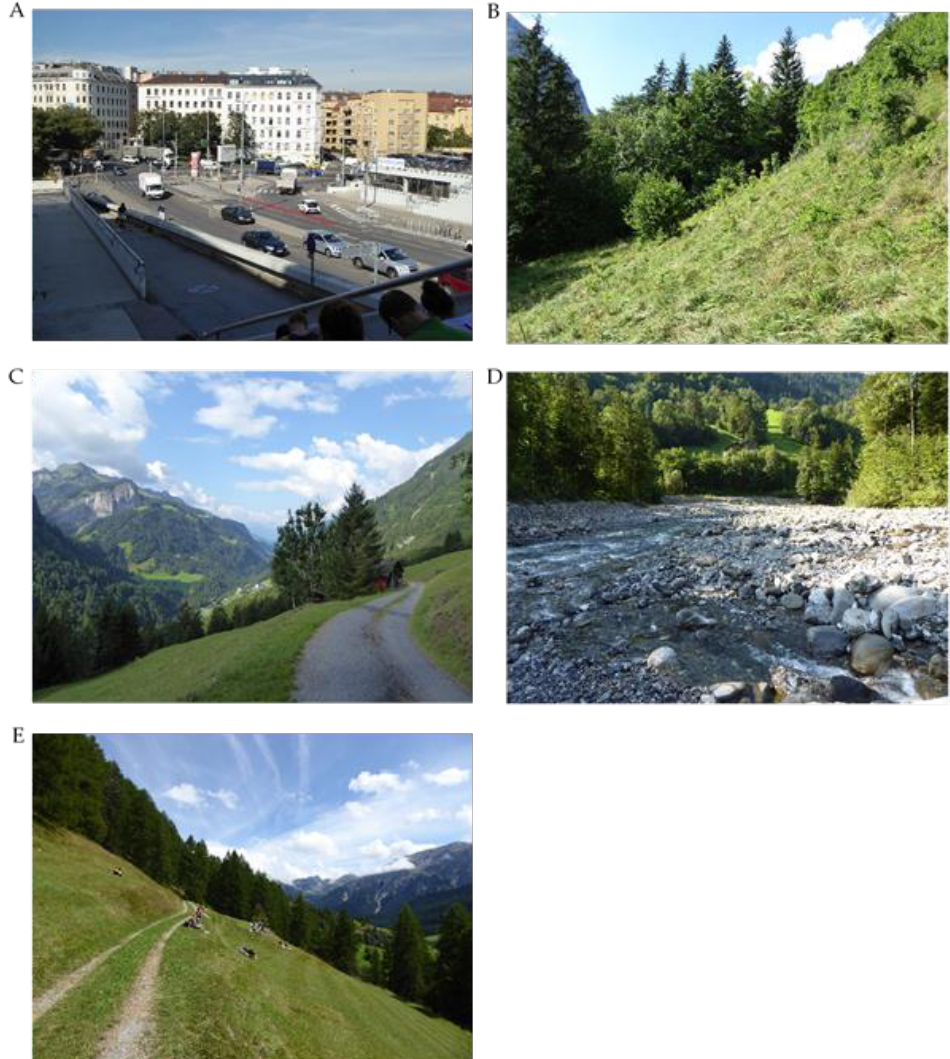
Figure 2. Photos of study sites ( A ) Vienna urban (U1, U2), ( B ) LTSER-region (M1), ( C ) Großes Walsertal (M2), ( D ) Lutz River, ( E ) Val Müstair (M3).